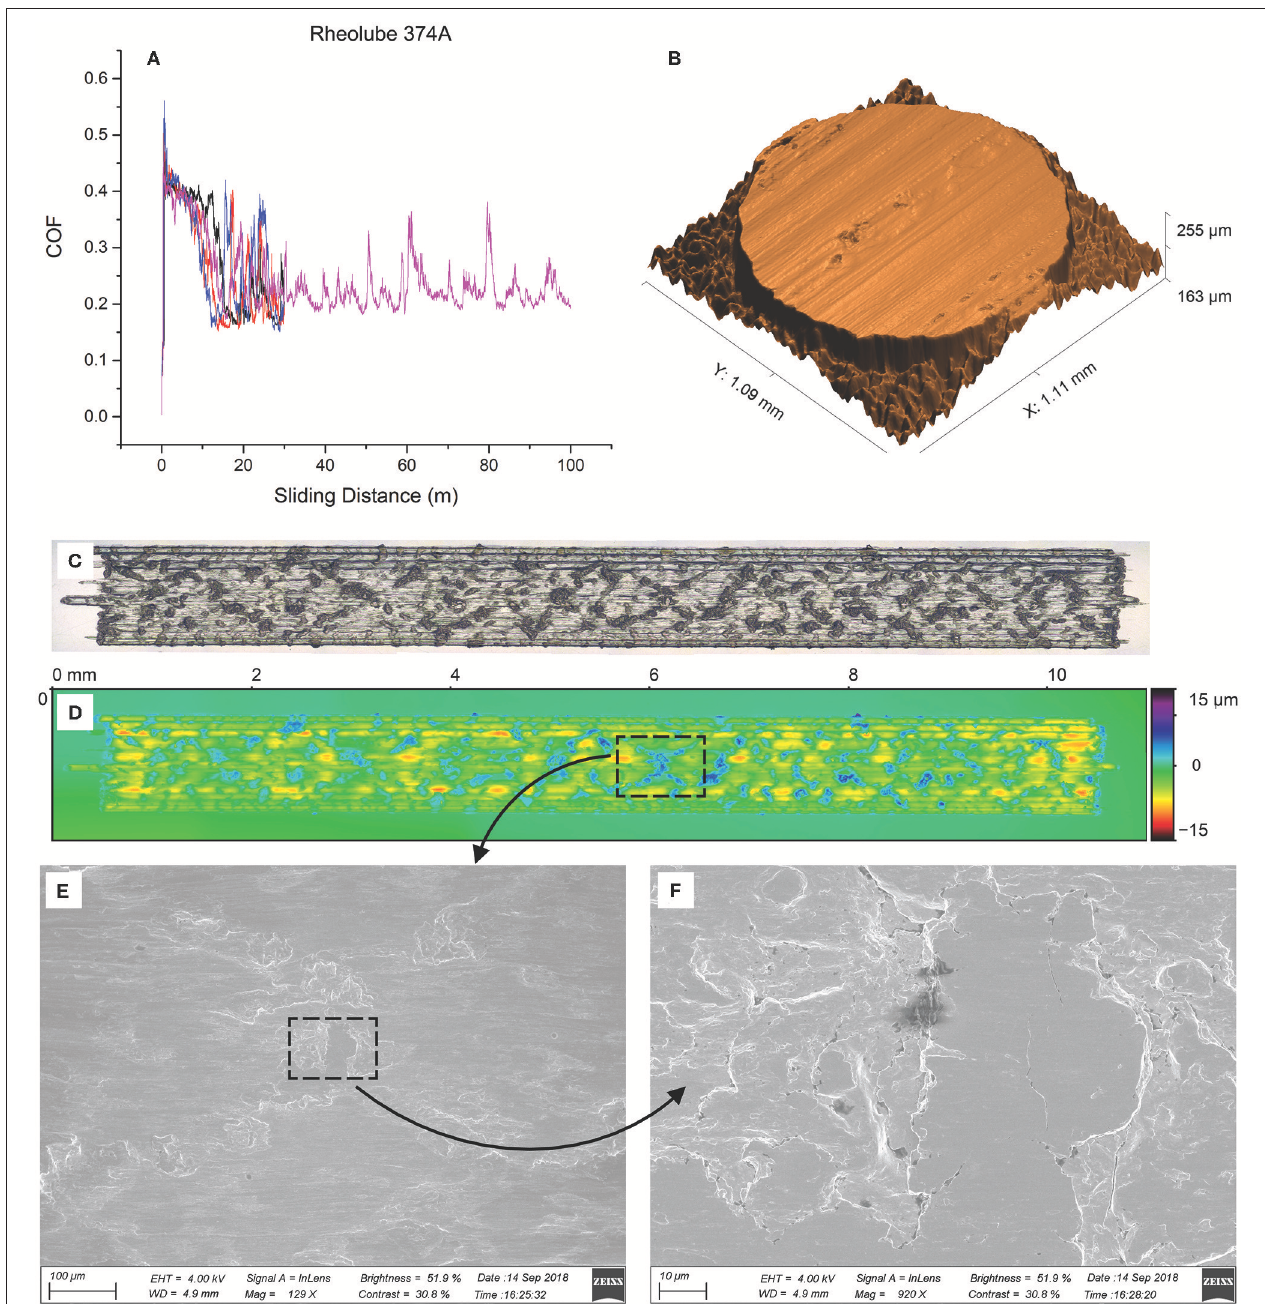
FIGURE 5 | Test results for Rheolube 374A including (A) friction traces, (B) interferometer image of the ball wear scar, (C,D) optical microscope and interferometer images of the flat wear scar, and (E,F) SEM micrographs of the flat wear scar. All wear images correspond to the test shown in red in (A) .